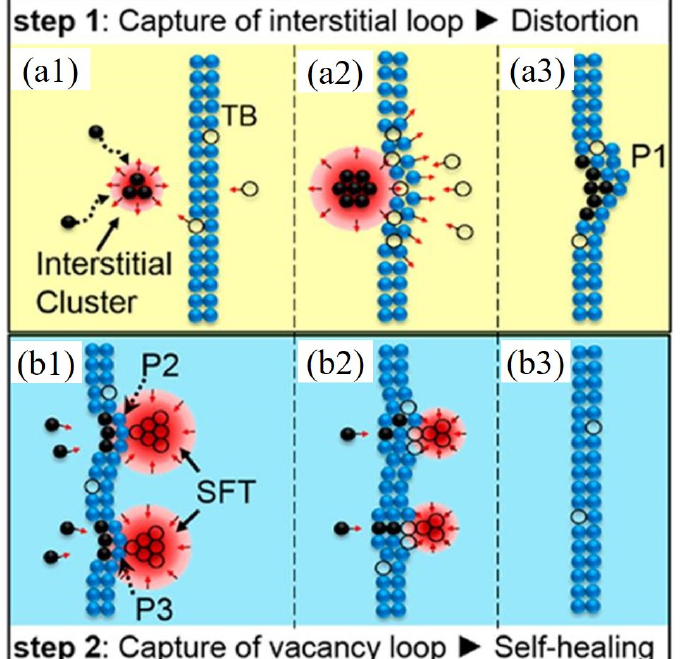
Figure 8. Schematics of the distortion and self-healing of a coherent twin boundary (CTB). ( a1 – a3 ) twin boundary captures interstitial atoms and becomes distortion. ( b1 – b3 ) twin boundary captures vacancies and becomes self-healing. Reproduced with permission from Ref. [81]. Copyright 2015 American Chemical